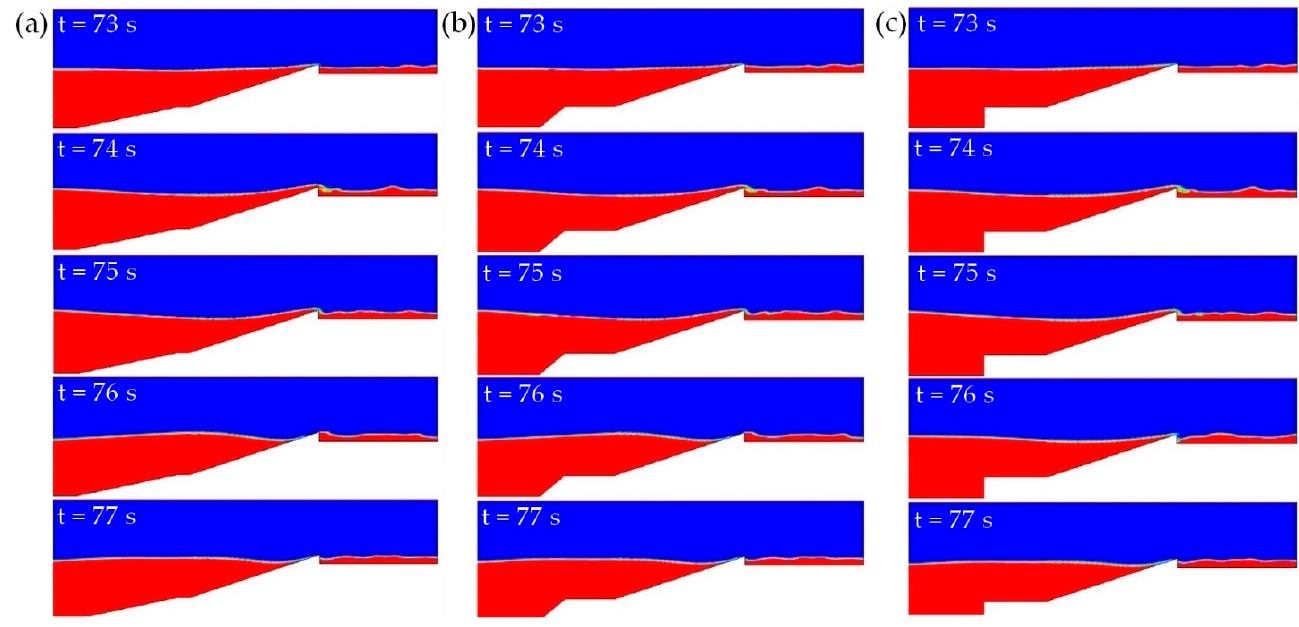
Figure 9. Influence of ratio H 3 / L 3 over once-maximized mass of water and corresponding optimal ratios of L 1 / L 2 .